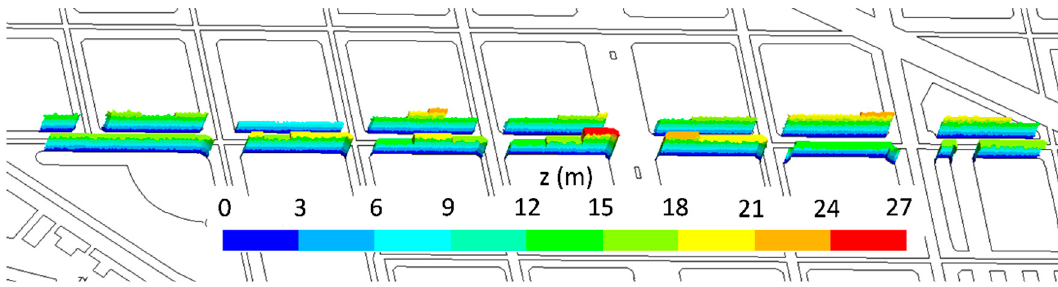
Figure 4. Vertical layout of buildings of the study street, with indication of the building height.